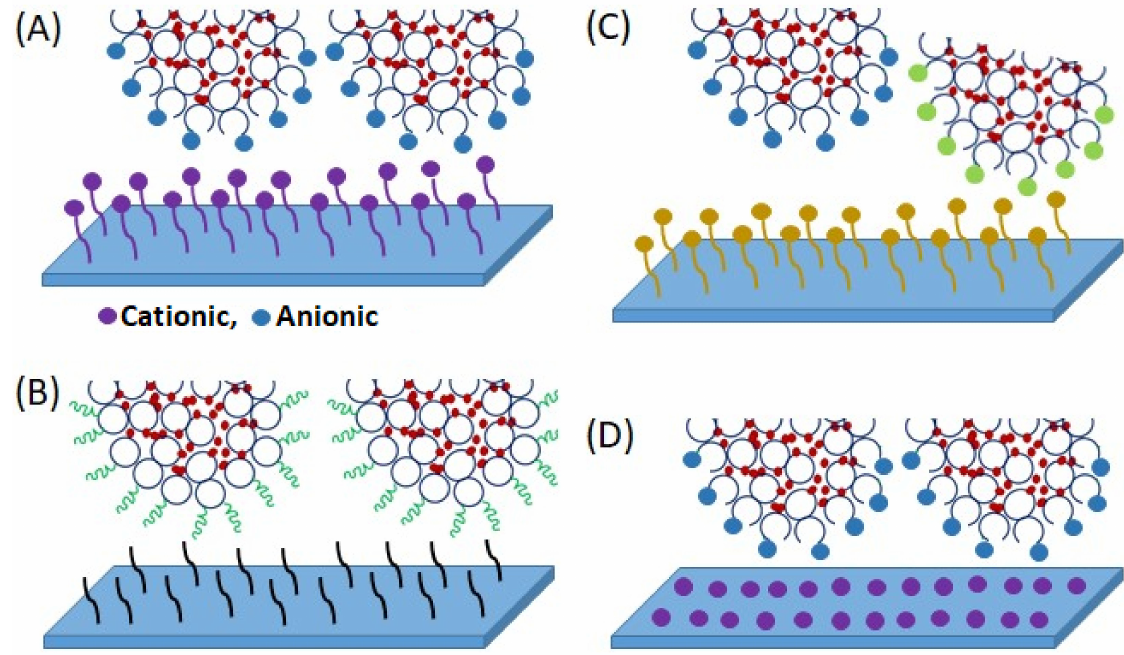
Figure 2. Different types of interactions between protein molecules and membrane/modified mem- brane: ( A ) ion-exchange (Self-developed, concept was adopted from Sun et al., 2011 [93], Reif and Freitag, 1993 [94]), ( B ) hydrophobic interaction (Self-developed, concept was adopted from Chen et al., 2017 [95], Tennikova and Svec, 1993 [96]), ( C ) affinity (Self-developed, concept was adopted from Zou et al., 2001 [97], Lalli et al., 2018 [98]), and ( D ) mixed matrix (Self-developed, concept was adopted from Avramescu et al., 2003 [99], Saufi and Fee, 2013